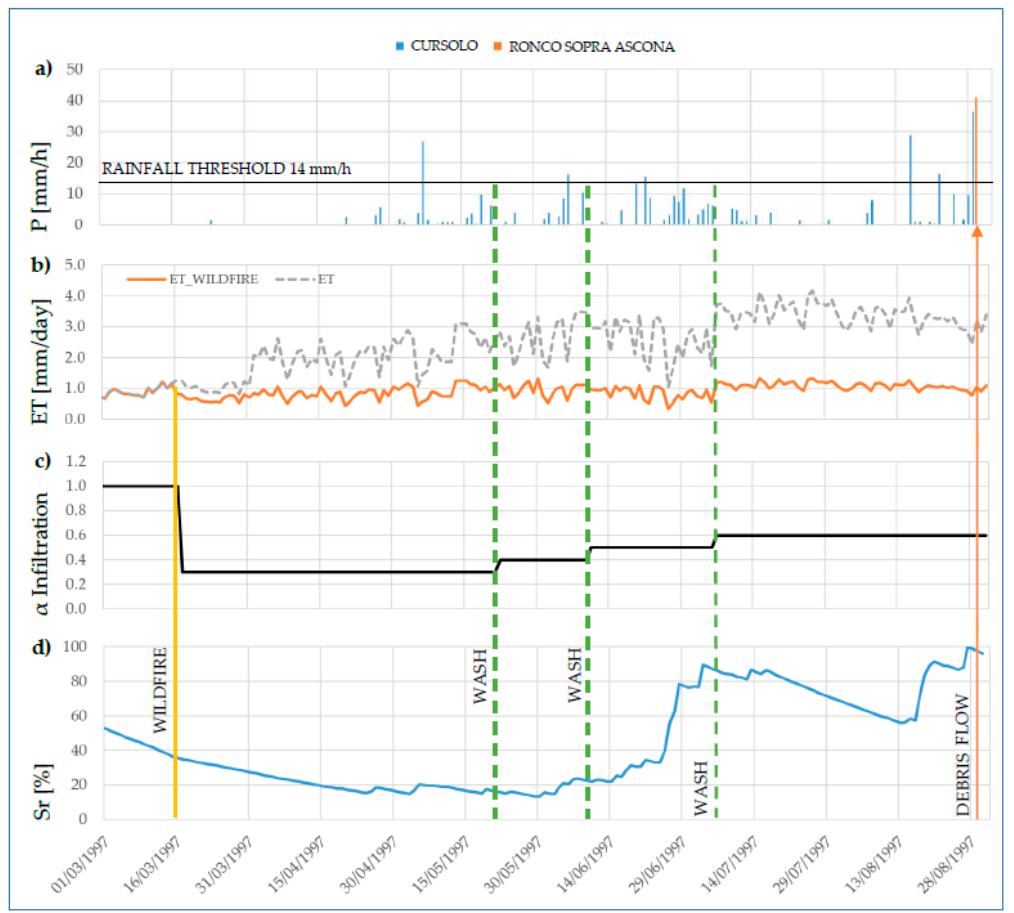
Figure 6. For the Ronco sopra Ascona area: ( a ) Rainfall series recorded; ( b ) wildfire effects on Evapotranspiration; ( c ) wildfire effects on Infiltration coefficient α ; ( d ) model simulation of the terrain’s degree of saturation. The vertical lines report the Wildfire event and the Wash events for infiltration recovery and Debris flow events.